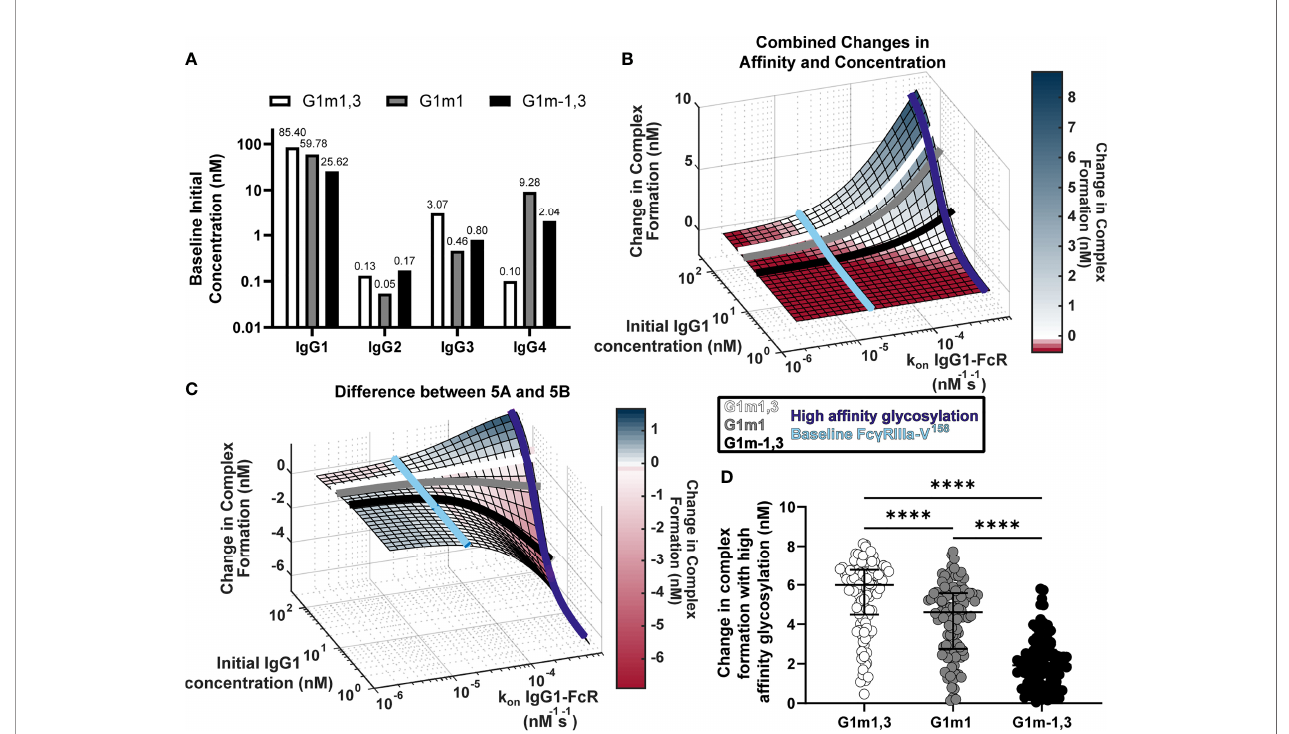
FIGURE 4 | Glycosylation differentially impacts IgG1 allotypes. (A) Expected IgG1, IgG2, IgG3, and IgG4 concentrations for G1m1,3 (white), G1m1 (gray), and G1m- 1,3 (black) allotypes based on previously published work (17, 29). (B) Model predictions for complex formation as IgG1 concentration and k on IgG1- Fc g R are altered over physiological ranges ( Figure 2B ). Lines indicate IgG1 concentrations for three different IgG1 allotypes (G1m1,3 (white), G1m1 (gray), G1m-1,3 (black)), and the af fi nity change expected from an afucosylation glycosylation modi fi cation (purple) compared to baseline (light blue). (C) The difference ( Figure 2C ) between the combined parameter change surface ( Figure 2A ) and the additive surface ( Figure 2B ). Lines indicate IgG1 concentrations for three different IgG1 allotypes (G1m1,3 (white), G1m1 (gray), G1m-1,3 (black)), and the af fi nity change expected from an afucosylation glycosylation modi fi cation (dark blue) compared to baseline FcgRIIIaV158 (light blue). (D) Change in complex formation from baseline af fi nity to an afucosylated af fi nity in each allotype, G1m1,3 (white), G1m1 (gray), and G1m- 1,3 (black) (Friedman test with Dunn ’ s multiple comparisons test; ****p-value <